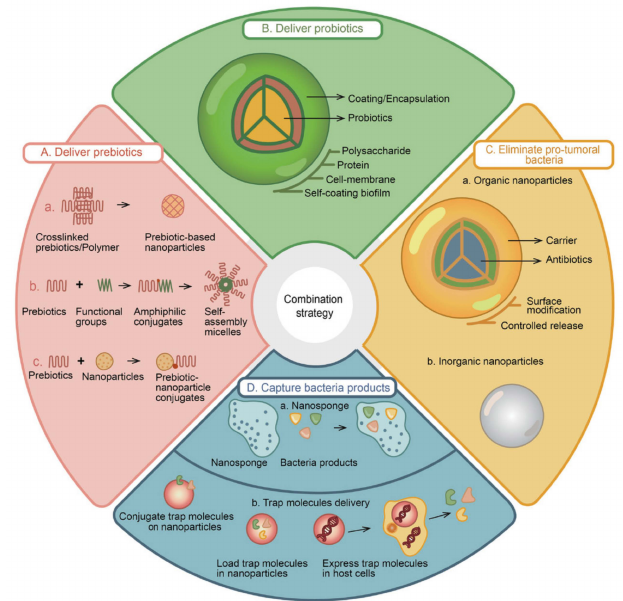
Figure 7. The modulation of microbiota by innovative drug delivery systems to improve cancer treatment outcomes. ( A ) Prebiotics can be applied in nanoparticles for drug delivery, conjugated with functional groups to form to nanoparticles alone or in combination with other cancer therapeutic agents. ( B ) Probiotics can be enclosed into nanoparticles to protect their bioactivities. ( C ) Eliminate pro-tumoral bacteria by targeted antibiotic delivery avoiding dysbiosis. ( D ) Nanoparticles can be designed to capture bacterial products or exhibit bacterial products inhibitors. Reprinted from [202] under a CC BY